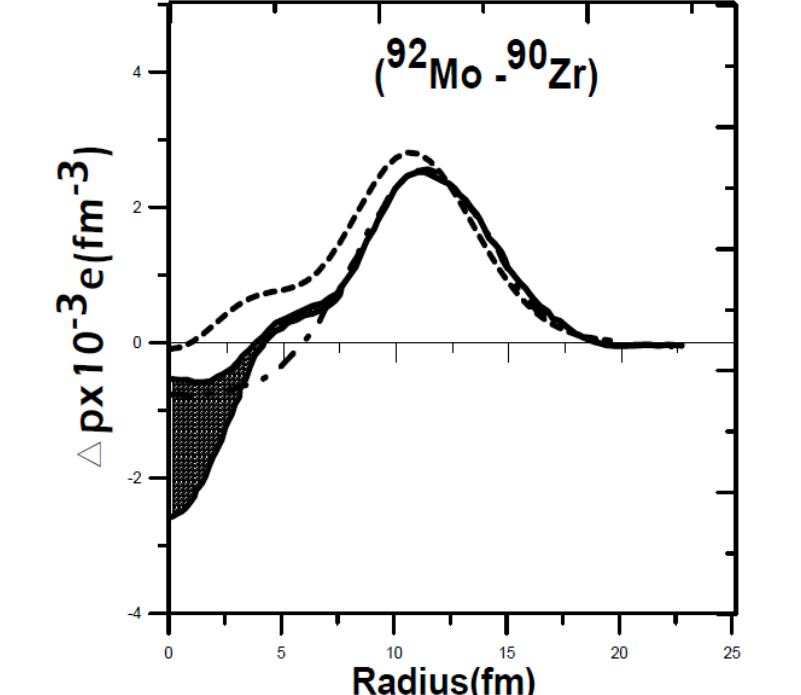
Fig.2: Dependence of the difference of the CDD of ( 92 Mo, 90 Zr) ( ) on (r). The solid curve is the calculated difference of the CDD with (d calculated difference of the CDD by Hartree - Fock (H.F) method with taken from Ref. [15], and the shaded area represents the calculated difference of the CDD with (d1,d2)=0 with the error